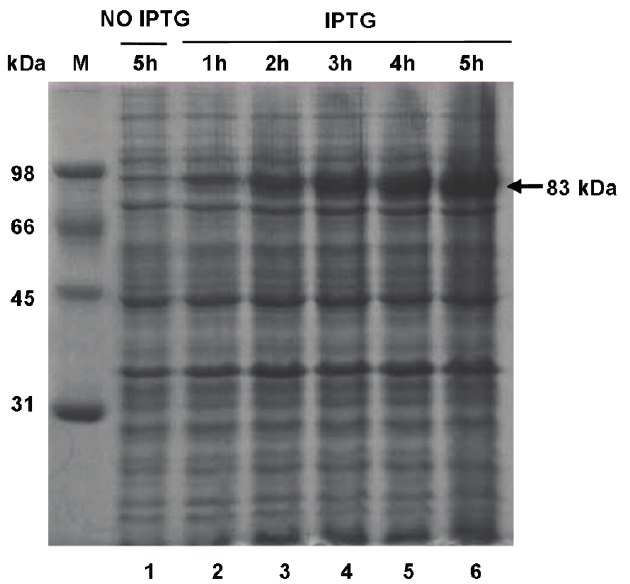
Figure 8. Expression of recombinant SsPAL1 protein in E. coli strain BL21. SDS-PAGE patterns of total crude protein under non-induced and induced conditions with a time course, visualized by Coomassie Brilliant Blue R250 staining. Lane 1: E. coli strain BL21 harboring the expression plasmid pET30a- SsPAL1 without induction by IPTG for 5 h; Lanes 2–6: E. coli strain BL21 harboring the expression plasmid pET30a- SsPAL1 induced by IPTG for 1, 2, 3, 4 and 5 h, respectively. M, protein molecular mass marker; the arrow indicates the recombinant SsPAL1 protein (including 6 KDa for tags).